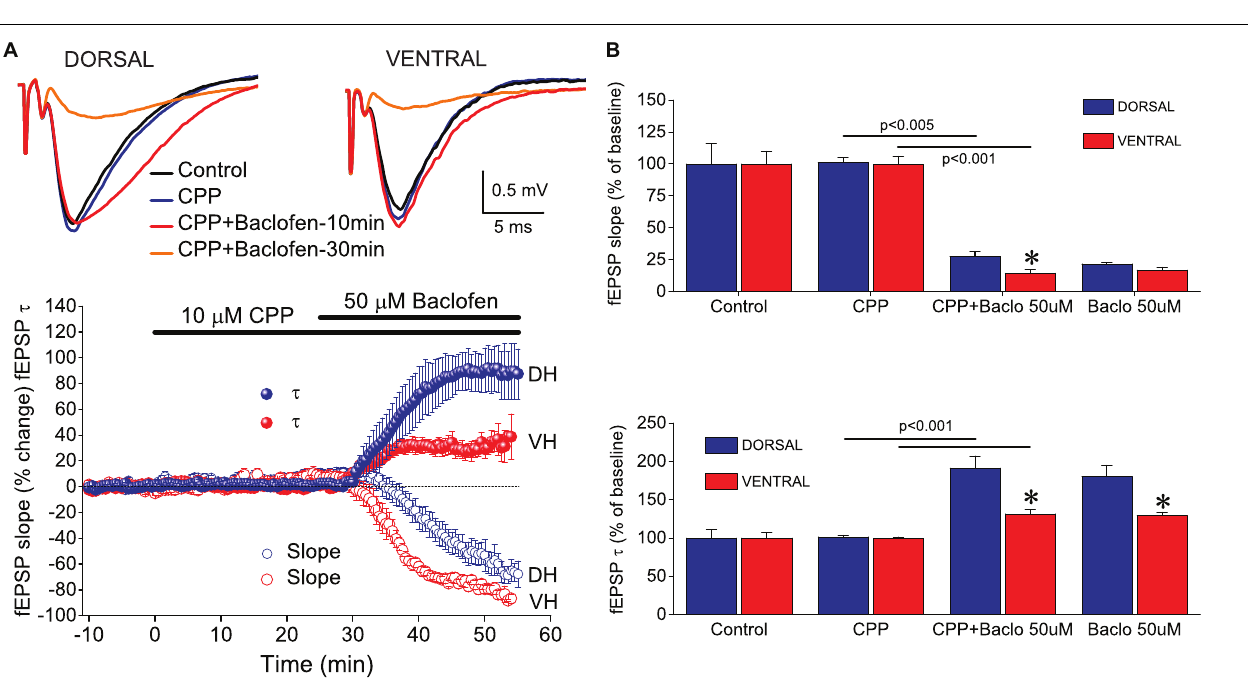
FIGURE 7 | Activation of GABA B Rs by baclofen suppresses fEPSP slope more in the ventral than in the dorsal hippocampus and prolongs fEPSP τ more in the dorsal than in the ventral hippocampus. Collective time courses of percent change of fEPSP slope and fEPSP τ illustrating the action of baclofen in the dorsal hippocampus and the ventral hippocampus are shown in panels (A,B) , respectively. In collective diagrams, values shown below and above zero correspond to changes in fEPSP slope and fEPSP τ , respectively. The number of slices studied is shown into parenthesis in collective graph legends. Data for 0.5 µ M (fEPSP slope ) and 50 µ M (fEPSP slope and fEPSP τ ) are not shown in collective graphs for clarity reasons. Representative examples of fEPSP traces, shown on the top of graphs, were collected under control conditions and under 5 or 50 µ M baclofen. Calibration bars: 0.5 mV, 5 ms. Note that 5 µ M baclofen suppresses fEPSP slope more in the ventral than in the dorsal hippocampus and at the same time prolongs the decay phase of fEPSP in the dorsal but not the ventral hippocampus. Also note that a 5 min application of 50 µ M baclofen induces an increase in fEPSP decay phase in the dorsal but not the ventral hippocampus, i.e., before any change in fEPSP slope occurs (blue trace, baclofen 5 min). (C) Concentration-effect curves for baclofen actions on fEPSP slope . Curves were constructed using the Boltzmann function. The number of slices used is indicated in the legend. Dotted arrowed lines indicate EC 50 values for the ventral (VH, 2.57 µ M) and the dorsal hippocampus (DH, 5.98 µ M). The two curves differ significantly (non-linear regression analysis, p < 0.0001). (D) Concentration-effect relationship of baclofen actions on fEPSP τ . The number of slices used for all baclofen concentrations, but 50 µ M, is shown in panel (B) ; the effects of 50 µ M baclofen were studied in eight dorsal and five ventral hippocampal slices. (E) Graph of cumulative time courses of baclofen-induced changes in fEPSP slope and fEPSP τ (suppression and enhancement, respectively) in the dorsal and the ventral hippocampus, constructed by pooling data from all baclofen concentrations. Lines on both sides of symbols indicate SEM. The number of slices studied in given into parenthesis. Arrow depicts the start of baclofen application (time = 0), which continues for the next 30 min. The inset graph on the top-left of panel shows the mean values of fEPSP τ under control and drug conditions. Asterisks indicate statistically significant differences at p < 0.05 (paired t -test and independent t -test were used for comparisons inside and between hippocampal segments, respectively). Note that under control conditions the value of fEPSP τ is higher in the ventral than in dorsal hippocampus; following baclofen application the value of fEPSP τ becomes similar in the two hippocampal segments. The inset graph on the bottom-left of the panel shows that baclofen-induced suppression of fEPSP slope was significantly higher in the ventral than in dorsal hippocampus (asterisk, independent t -test, p < 0.05). (F) Are shown time course diagrams (graph on the left), example traces of fEPSP recordings (upper-right panel) and aggregate data under control and